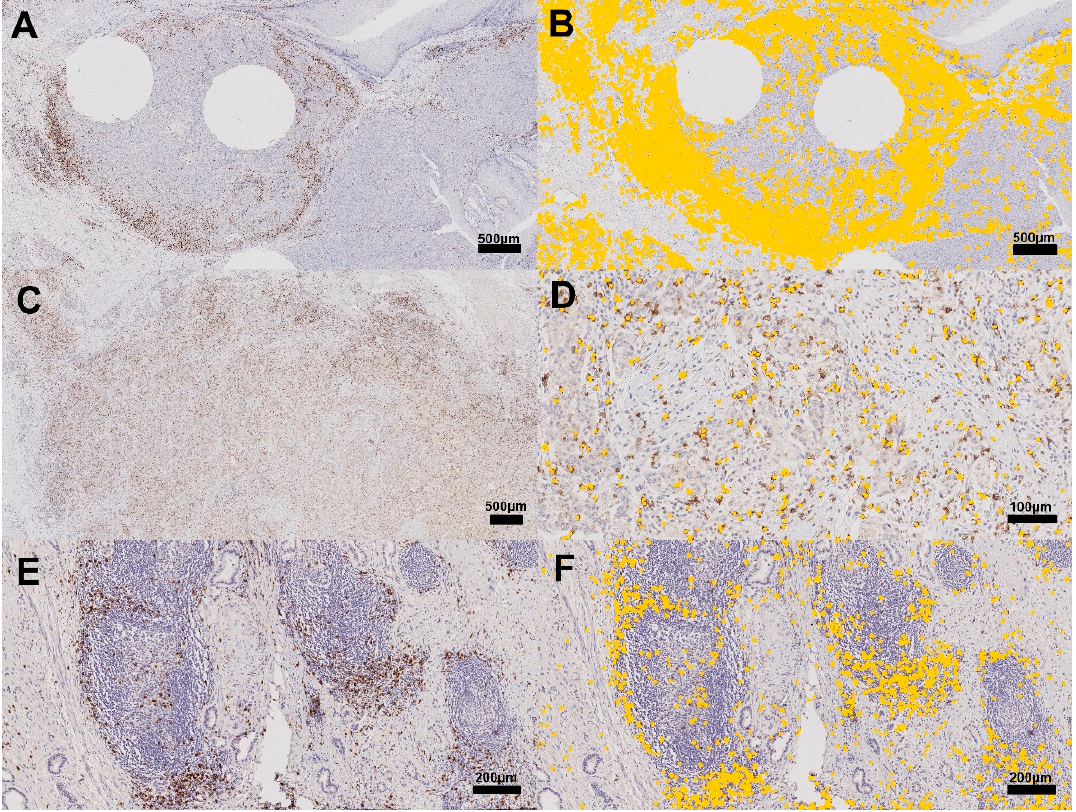
Figure 3. General types of TIME. We used the definition of the different types of TIME by Binnewies et al. [14] to divide our cohort. Samples were stained with an anti-CD8+ antibody ( A – F ). The cytotoxic T cells (CTLs) were marked with a yellow dot using the Definiens Tissue Studio ( B , D , F ). In the infiltrated-excluded phenotype CTLs are around the tumor ( A , B ). In the infiltrated-inflamed phenotype CTLs are in the tumor center ( C , D ). In the TLS-TIME phenotype tertiary lymphoid structures and lymphoid aggregates are found ( E , F ).